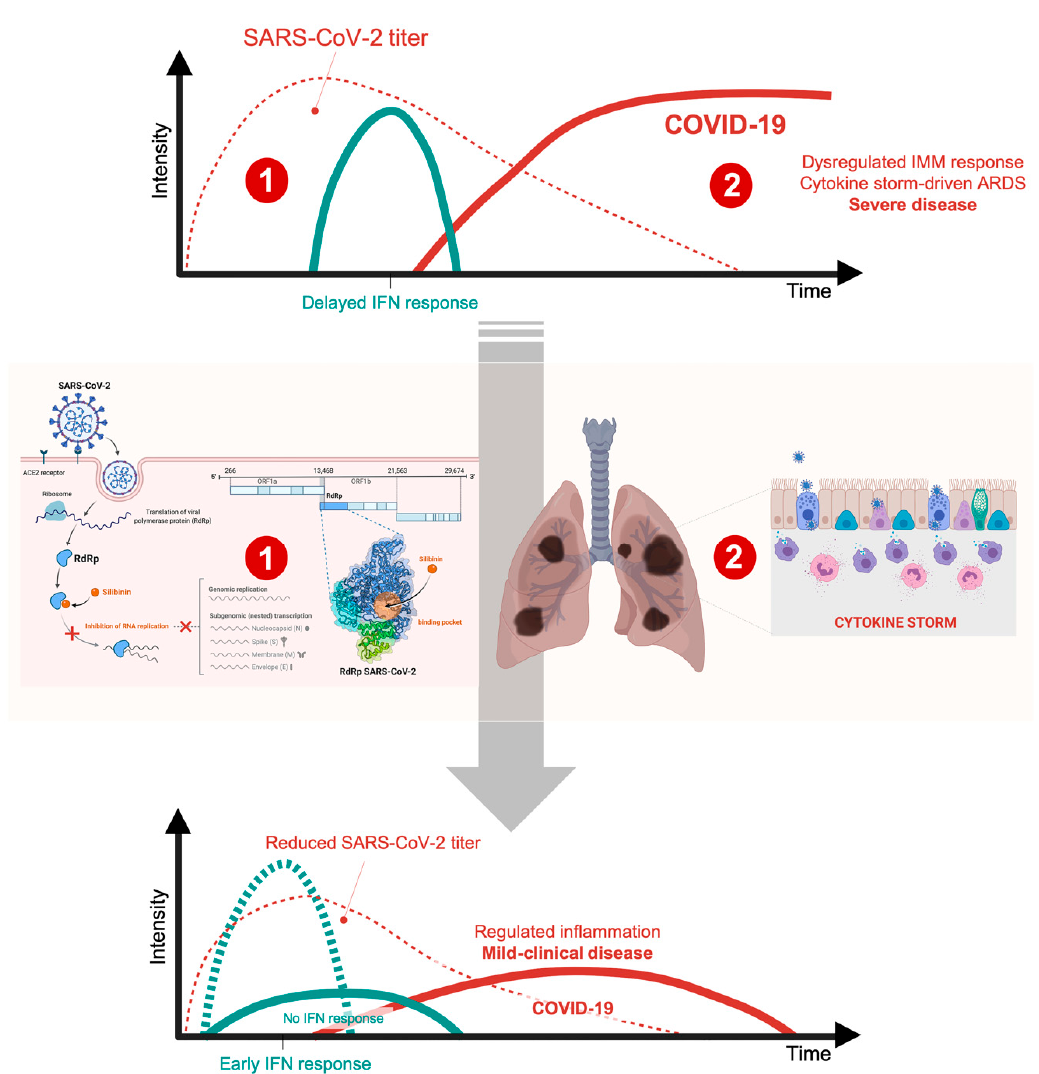
Figure 2. Silibinin: a putative regulator of the too-little-too-late interferon response in COVID-19. Whereas it is well known that type I-interferon (IFN)-induced anti-viral response is among the earliest and most potent of the innate responses to fight viral infection, the timing of IFN-I response relative to virus replication might be key for SARS-CoV-2 infection outcome. (1) The extremely rapid and robust replication of SARS-CoV2—while IFN-I expression is delayed—is one of the initial triggers of lung inflammation, therefore highlighting the relevance of reducing initial viral load through direct anti-viral interventions. By targeting the central component of the replication/transcription machinery of SARS-CoV-2, namely the viral polymerase RdRp, silibinin is expected to reduce viral load and/or impede delayed interferon responses. The early antagonism of several SARS-CoV-2 proteins to the IFN response delays or prevents the innate immune response. Delayed IFN signaling, however, further orchestrates inflammatory monocyte/macrophage (IMM) responses and sensitize T-cells to apoptosis, which results in a further dysregulated inflammatory response, cytokine-driven acute respiratory distress syndrome (ARDS), and severe/fatal disease in a subgroup of COVID-19 patients. (2) Silibinin might be expected to phenotypically integrate the mechanisms of action of IL-6-targeted monoclonal antibodies and pan-JAK1/2 inhibitors to alleviate the pathological accumulation of inflammatory macrophages as the source of the cytokine storm and T-cell lymphopenia associated